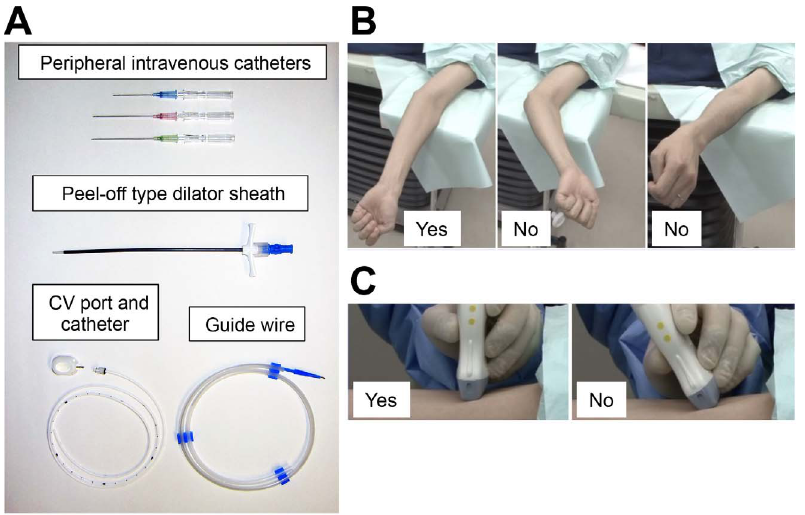
Figure 3. Preparation. ( A ) Minimum specific materials for the procedure. In this kit, a CV port/catheter, a dilator sheath, and a guide wire are supplied. For venipuncture, we use common peripheral intravenous catheters with appropriate lengths and gauge sizes through which a guide wire can be passed. In this kit, an 18-gauge needle is sufficient. In case of ‘‘Seldinger technique’’-based kits, a 20- or 22-gauge needle might be sufficient because those guide wires are usually thinner than ‘‘peel-off sheath’’-based kits. Further, commonly used materials such as surgical caps, masks, eye protection, sterile gloves, gowns, drapes, disinfectant sponges, gauzes, sutures with needles, scalpels, anesthetic syringes, and 1% or 2% lidocaine anesthetic solutions are also required (not shown). ( B ) Arm position. The patient should be asked to lie down in the supine position, which allows the upper limb to abduct, upper arm to rotate outward, forearm to supinate, and medial side of the arm to be upward for better demonstration of the basilic vein. The elbow should not be bent, and the forearm should not be pronated. ( C ) Tips for applying the probe with the correct angle. The probe should be applied at the correct angle.